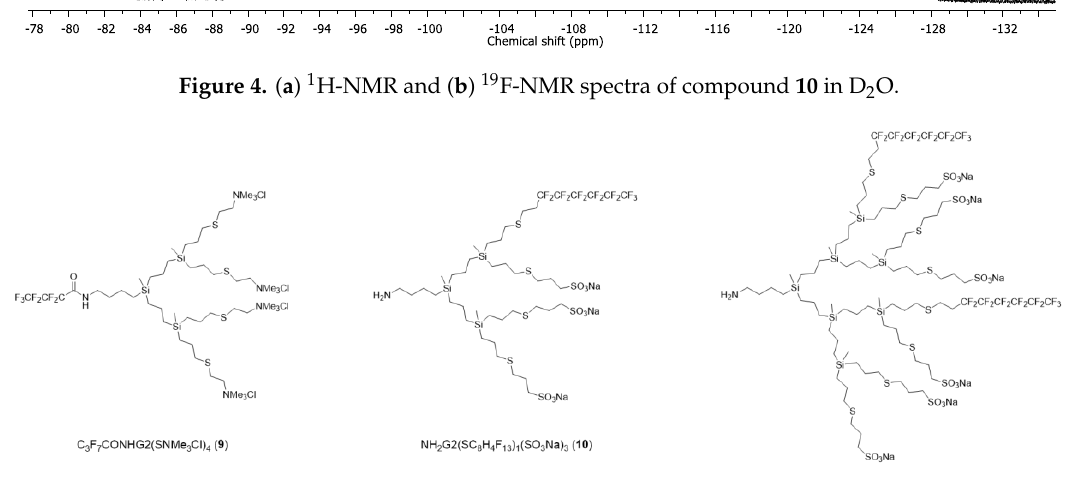
Figure 5. Representative structures of fluorinated carbosilane dendrons.